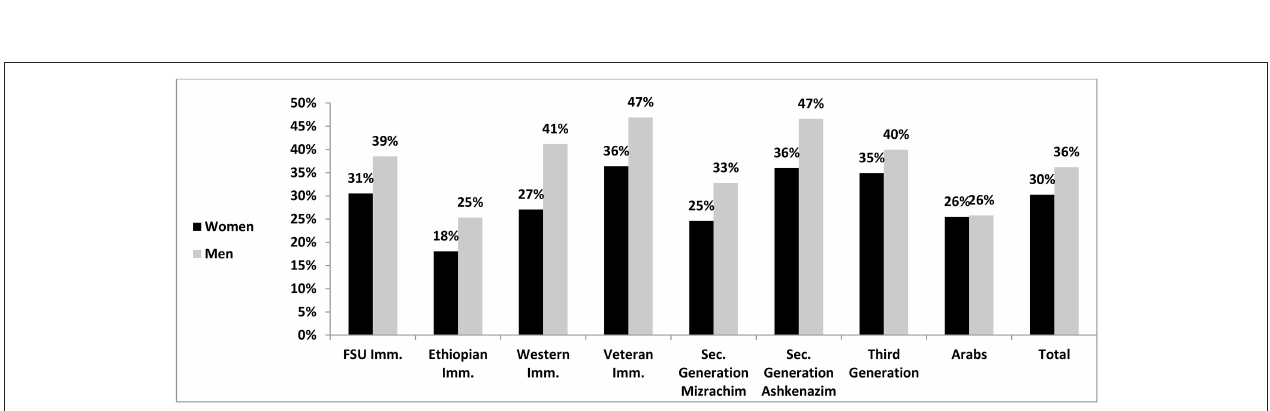
FIGURE 1 | Positive subjective mismatch in the labor market position by ethnicity and gender. Imm., immigrants; Sec., second; Miz., Mizrahim; Ashk., Ashkenazim.